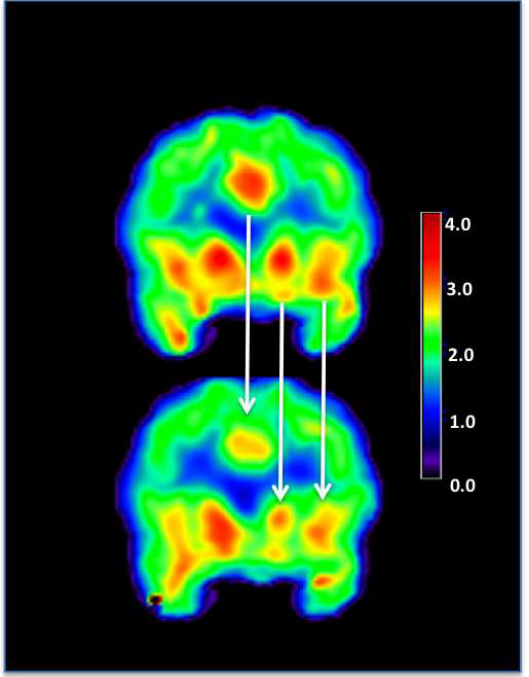
Figure 4. An example of [ 11 C]carfentanil-PET image, taken from Dos Santos et al. 2012 [53]. Decrease in µ-opioid receptor (µ OR) binding associated with transcranial direct current stimulation. Upper panel: µ OR BPND during the baseline PET. Lower panel: µ OR BPND during active tDCS. ACC = anterior cingulate cortex; NAc = nucleus accumbens; Ins = insula; BPND = non-displaceable binding potential. The color bar describes increasing (µ OR) binding increasing signal intensity (from black to red).